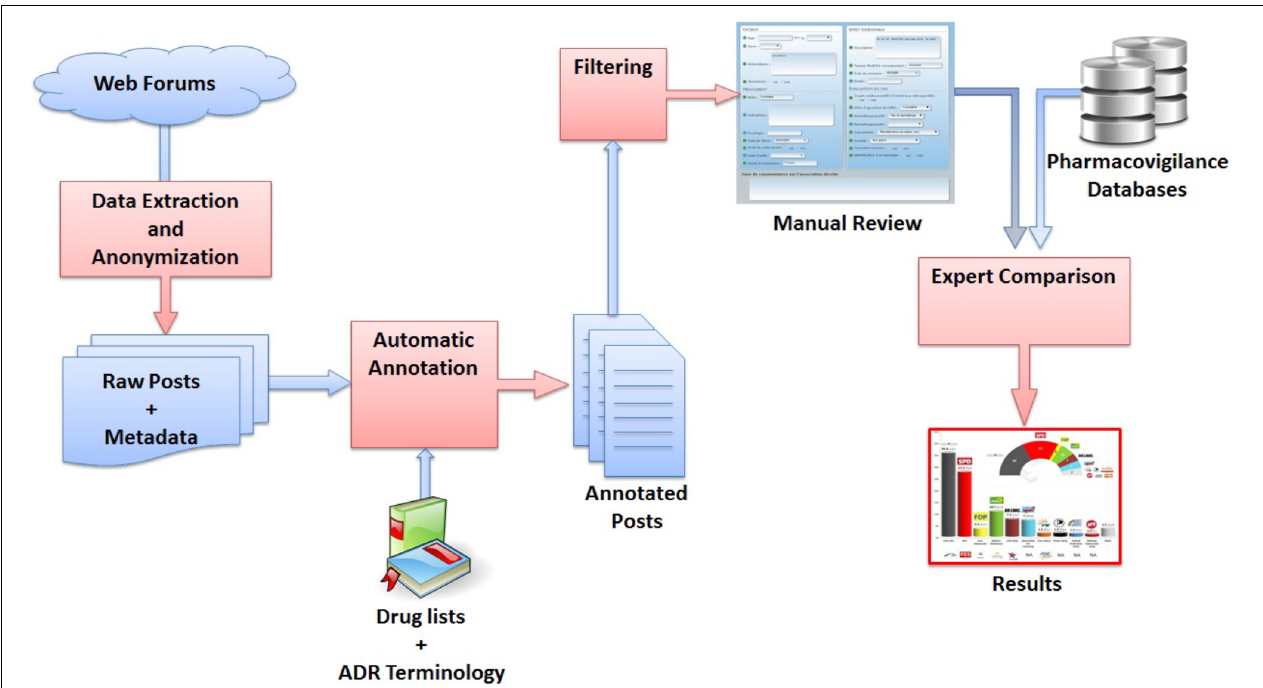
FIGURE 1 | General overview of the Vigi4Med project.